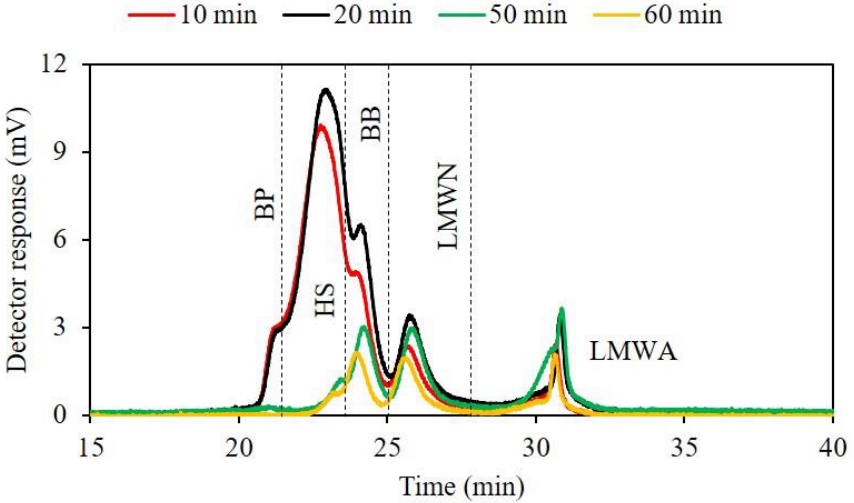
Figure 6. MW distribution in rainwater sampled on 27 July 2019. BP: biopolymer; HS: humic substances; BB: building blocks; LMWN: low MW neutral; LMWA: low MW acid.